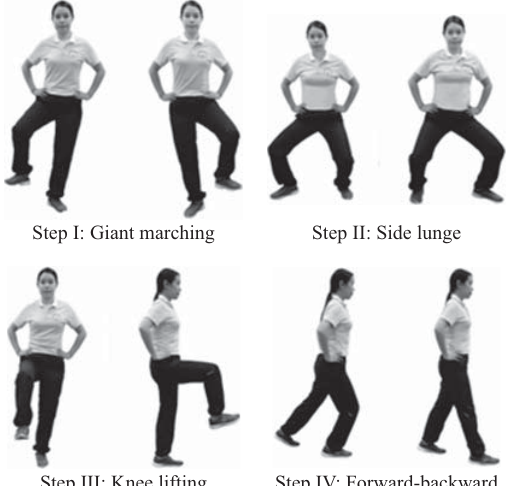
Figure 1. Leg movements of Khon